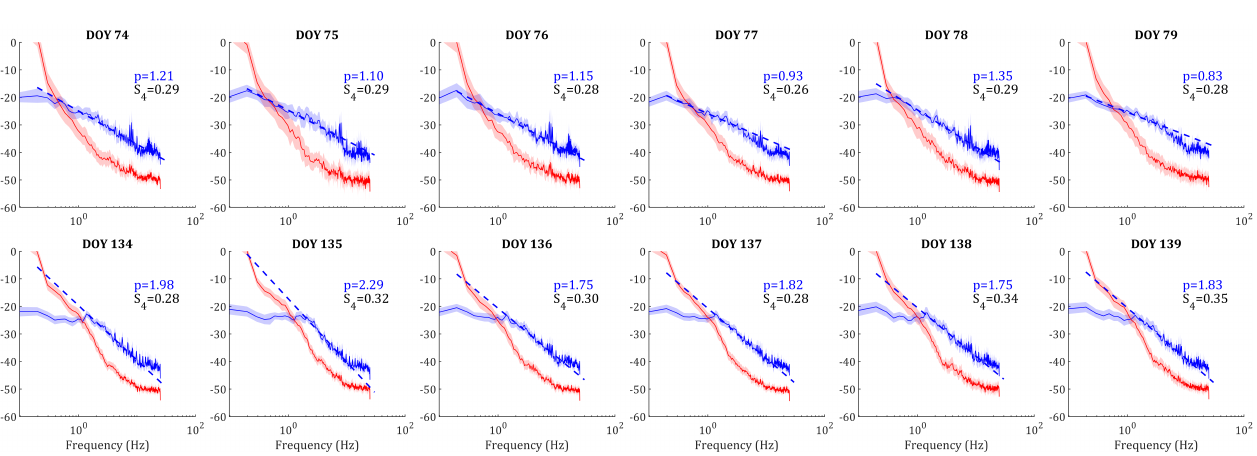
Figure 11. Daily averaged PSDs for label 0 observations. Blue curves correspond to intensity, red corresponds to phase, and shaded regions to the 95% confidence interval. Spectral slopes are in general shallower than the ones observed in the averaged intensity PSDs of label 1 measurements. Phase PSDs do not follow closely the intensity slopes at the high–frequency end. The S 4 index corresponds to the average among label 0 cases in each day.